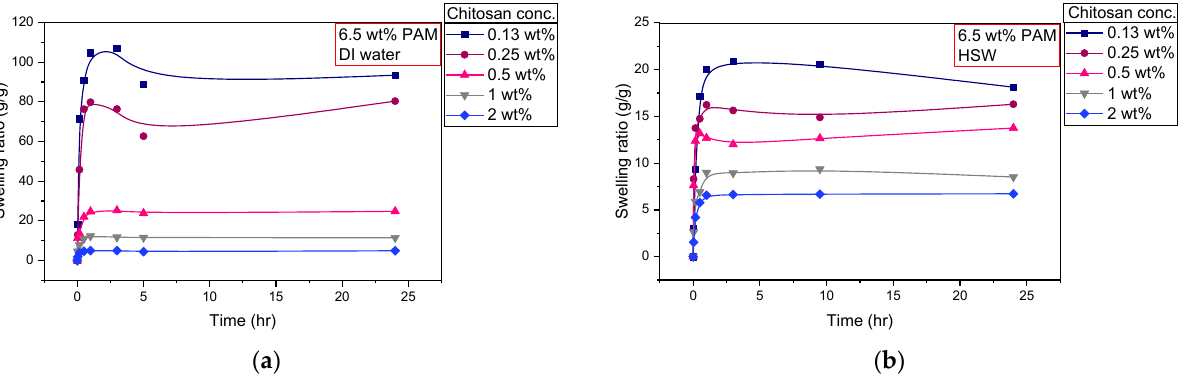
Figure 6. The effect of chitosan crosslinker concentration (0.13 – 2 wt%) on the swelling kinetics in different solution of: ( a ) DIW; and ( b ) HSW.